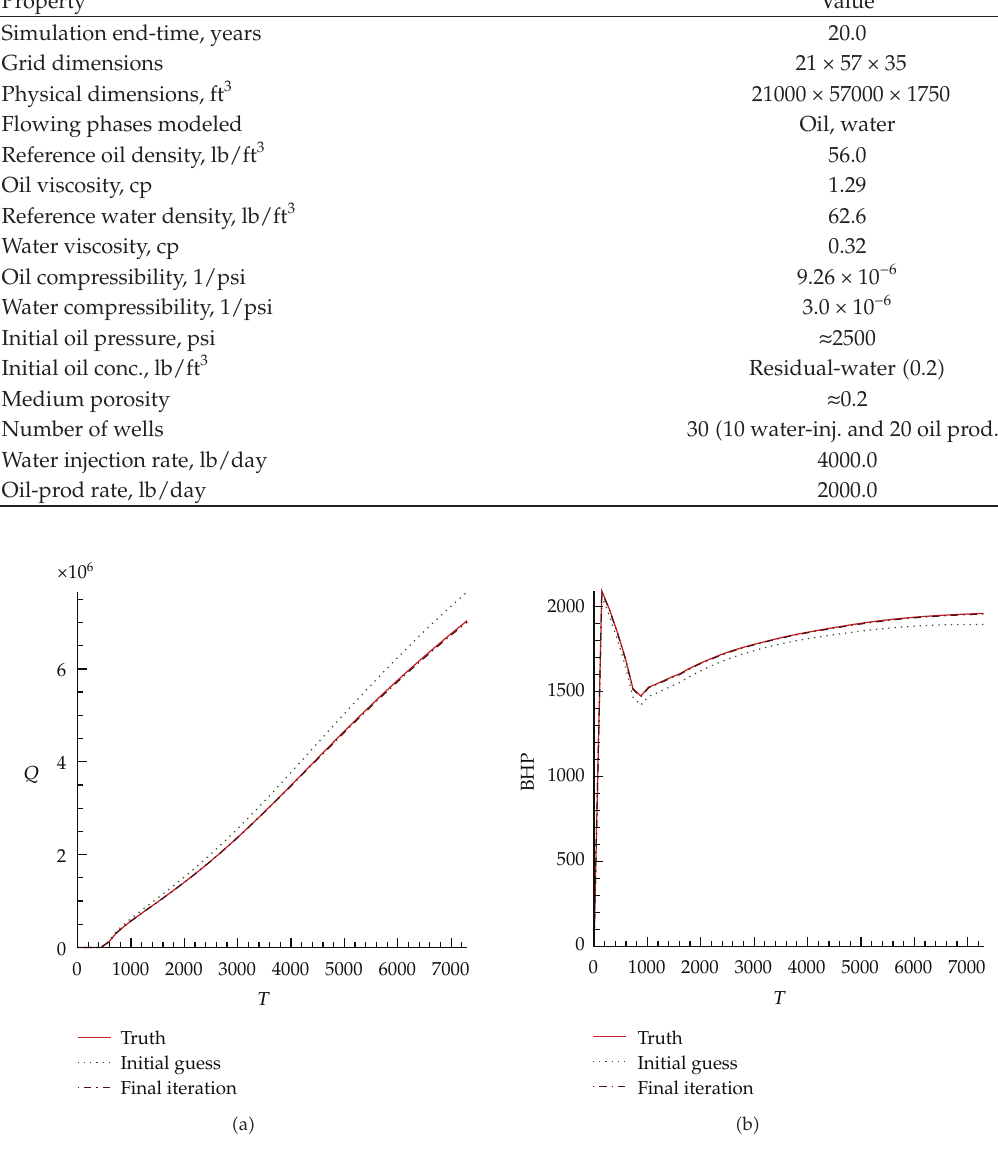
Figure 9: Example 2 (cid:6) Brugge field test (cid:7) : well 19 (cid:6) a (cid:7) production curves and well 21 (cid:6) b (cid:7) BHP history